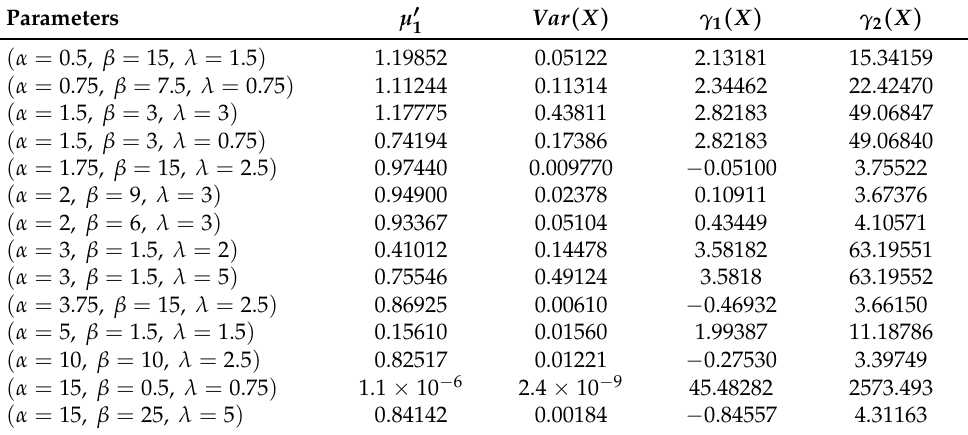
Table 1. The numerical values for µ (cid:48) choices of α , β , and λ